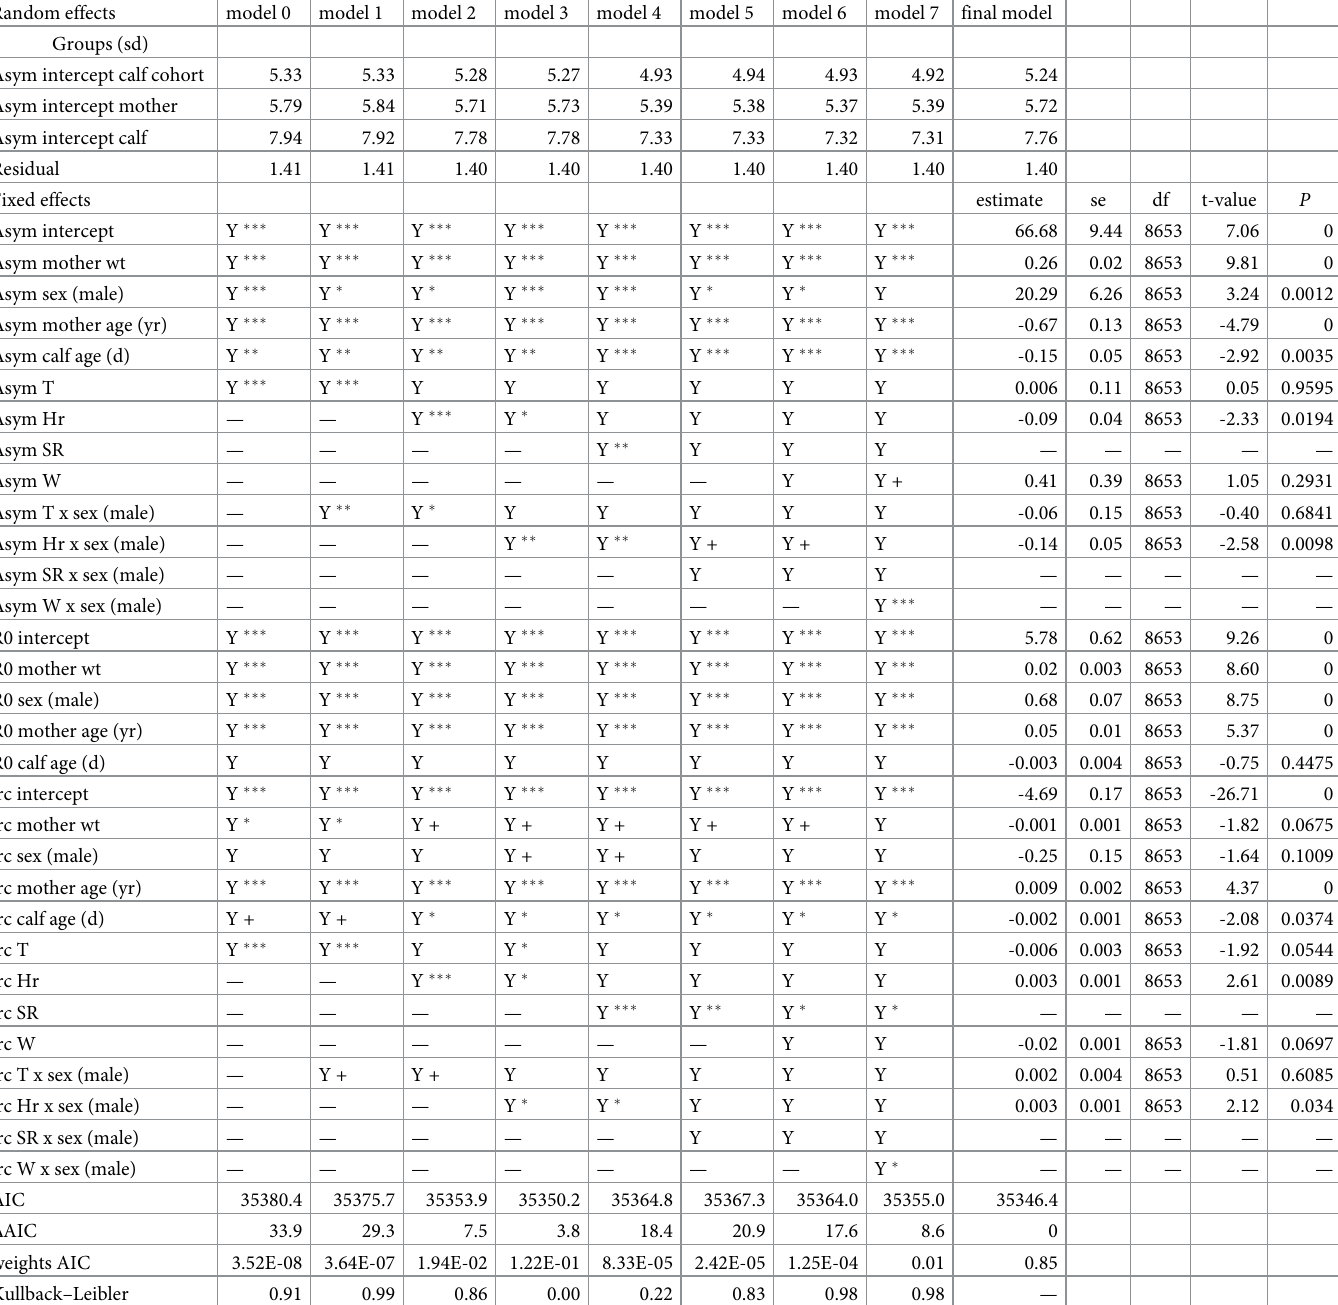
Table 4. Coefficients and statistics of an exponential asymptotic mixed linear model on calf weight (kg) controlling for animal and climatic variables. Female is the sex level of reference. Acronyms as in Table 2. Random